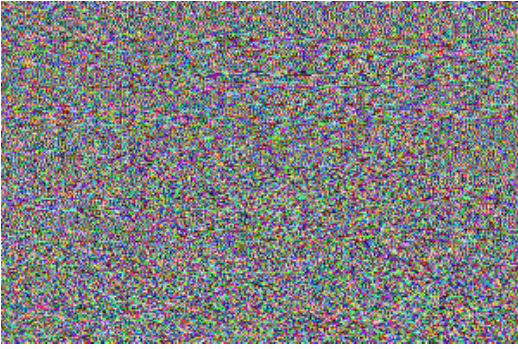
Figure 15. Post-encryption effect.